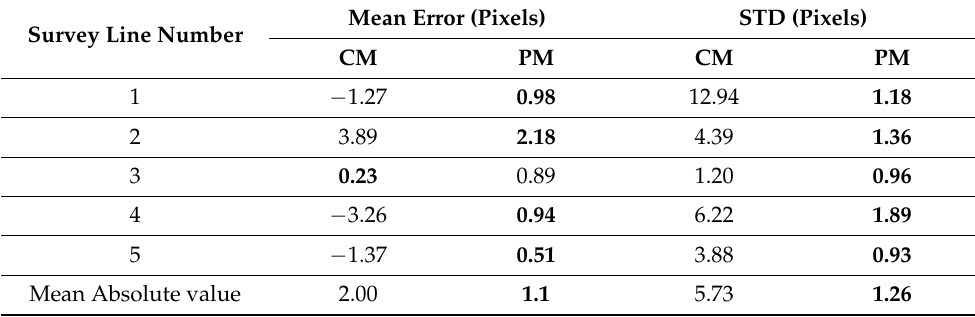
Table 1. Precision statistics of the bottom tracking results among the above tested data. Survey Line Number